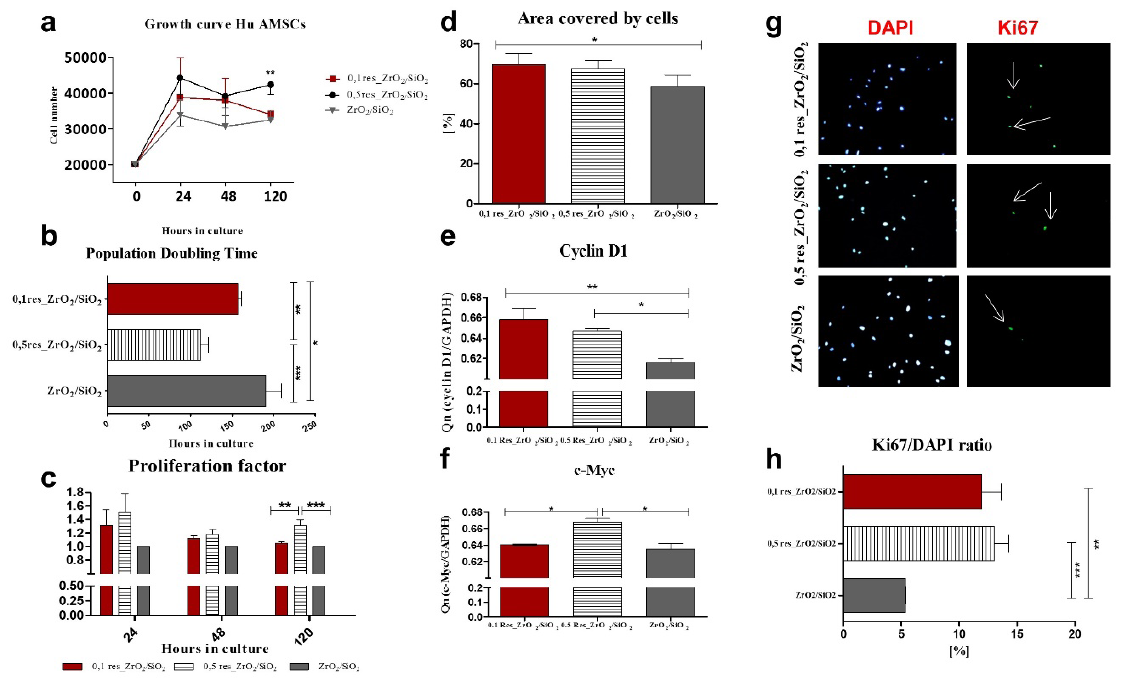
Figure 4: Growth kinetics of ASCs cultured on different sol/gel coatings. Growth curve of ASCs calculated during 5 days (a). Population Doubling Time (b) and Proliferation factor for each coating (c). Area covered by cells calculated from photographs obtained during the experiment (d). The expression levels of Cyclin D1 (e) and c-Myc (f) involved in cell cycle regulation. Ki67-DAPI staining of cultures (g) staining quantification (h). White arrows indicate the signal from the Ki67. Magnification: x100. Results expressed as mean ± SD